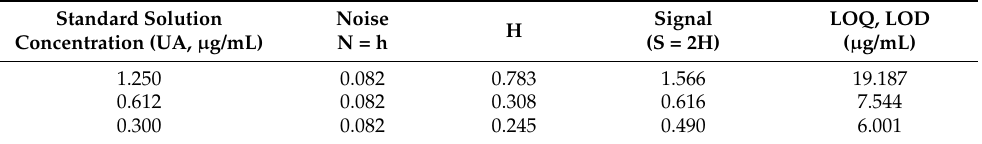
Table 4. Calculation of detection limit (LOD) and quantification limit (LOQ) values ( µ g/mL). Standard Solution Noise Concentration (UA, µ g/mL) N = h